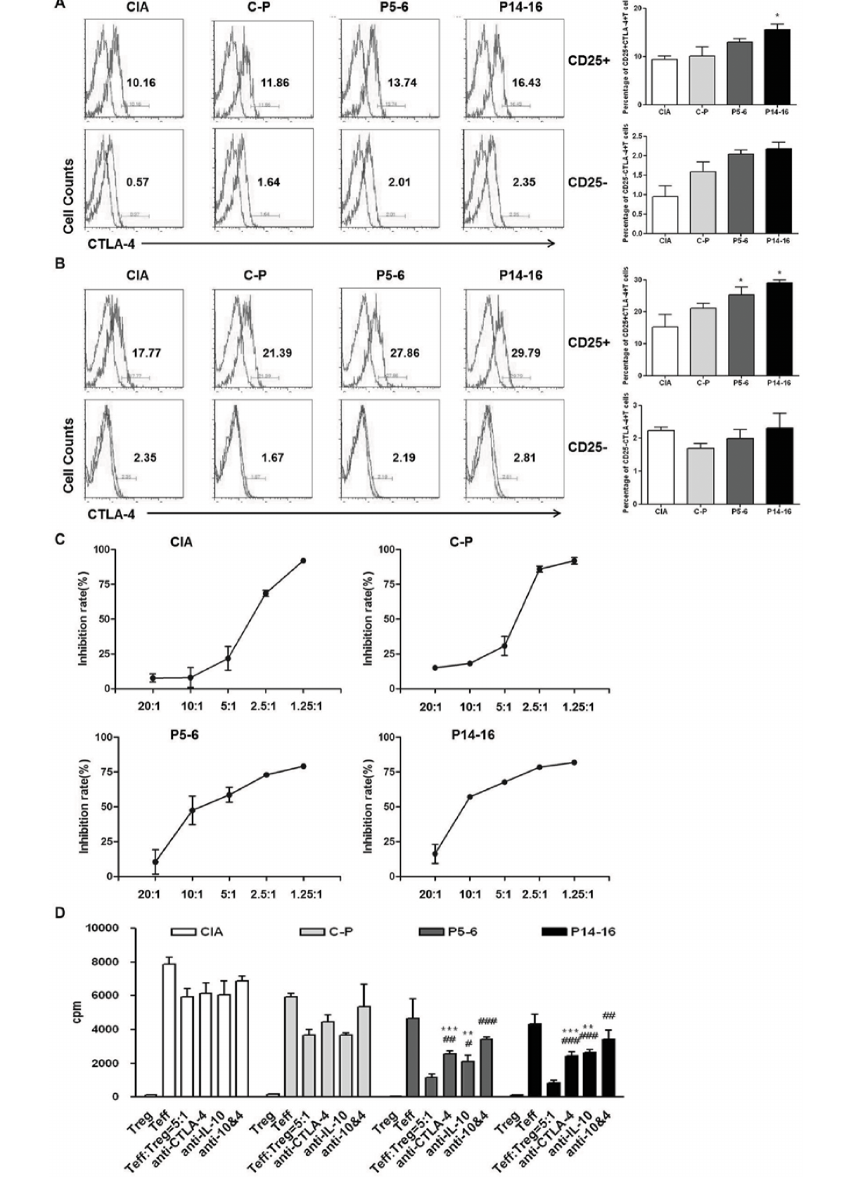
Figure 5. Treg function affected by ergotope peptide treatment. Flow cytometric analysis of CTLA-4 extracellular (A) and intracellular (B) expressions in CD4 + CD25 + (upper panel) and CD4 + CD25– (lower panel) splenocytes from untreated, C-P, P5–6 and P14–16 treated groups are shown. Statistical analysis is shown on the right. Values are the mean ± SD. *: P < 0.05 versus C-P group. (C) Inhibition rate